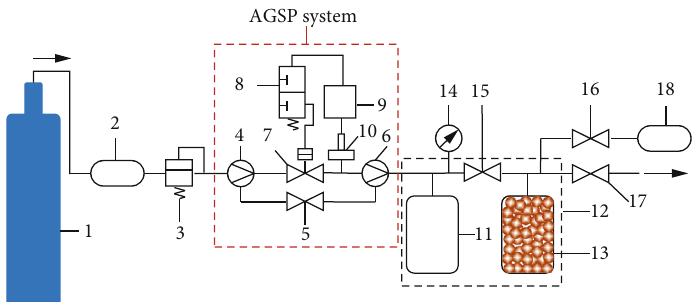
Figure 1: The equipment for shale matrix permeability determination with the AGSP system.